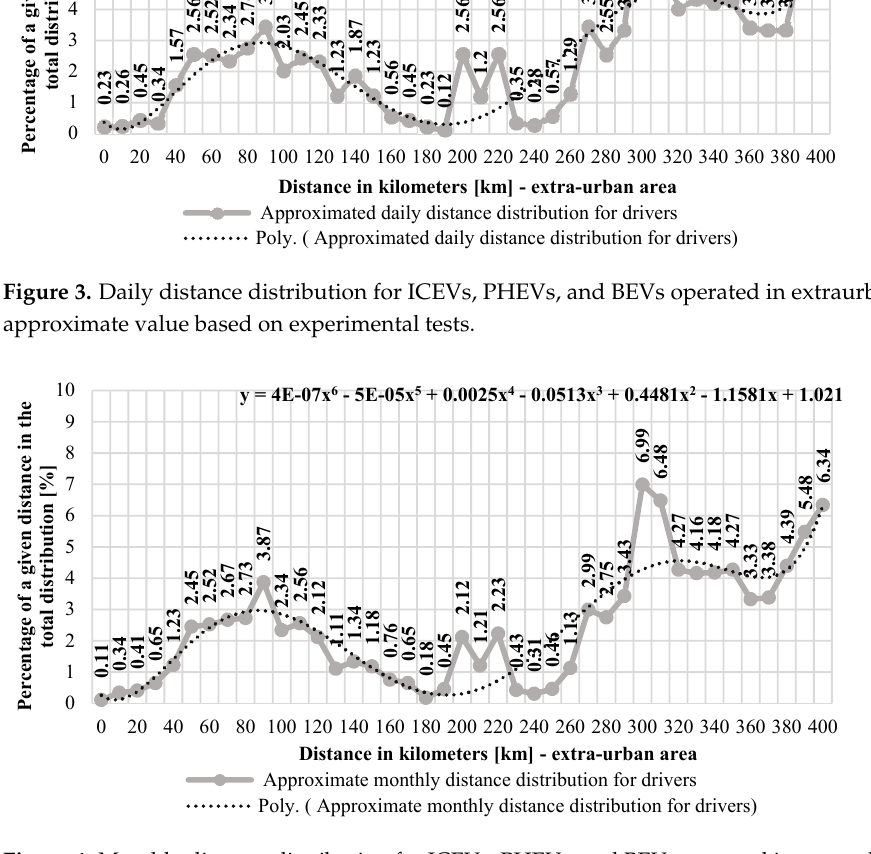
Figure 4. Monthly distance distribution for ICEVs, PHEVs, and BEVs operated in extraurban mode—approximate value based on experimental tests.